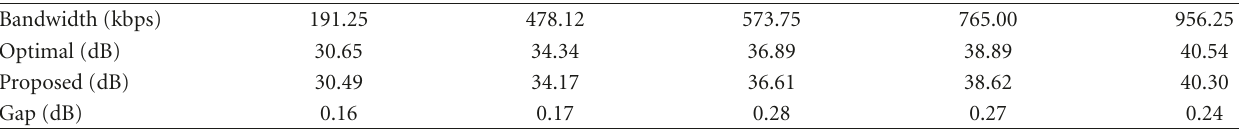
Table 3: Performance gap: mixed